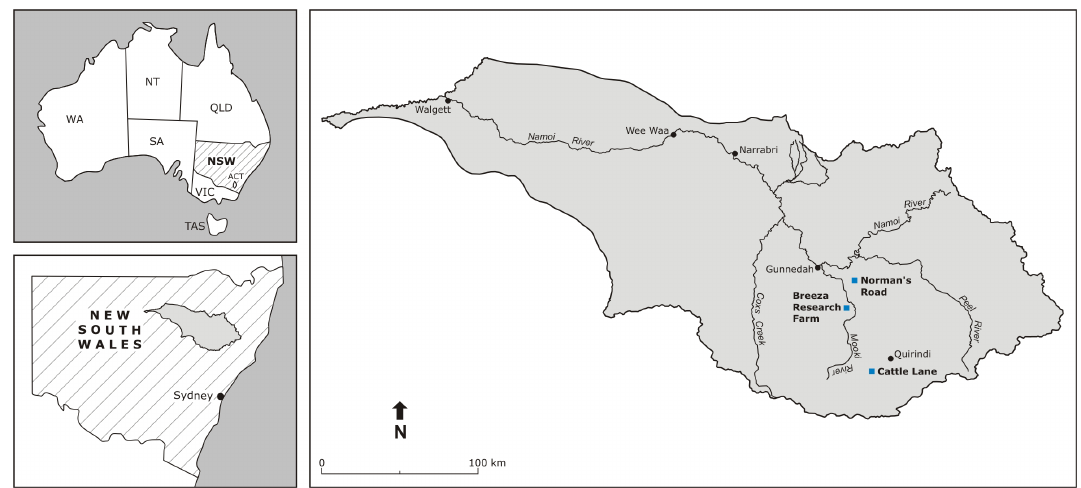
Figure 1. Location of study sites in eastern Australia, state of New South Wales (NSW). The Norman’s Road (NR), Breeza Farm (BF) and Cattle Lane (CL) sites are shown within the Namoi